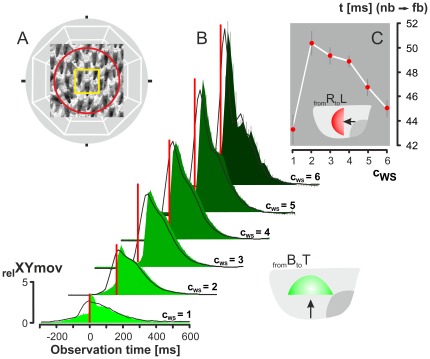
The time courses of wave strength of focus bees and their triggering neighbours.(A) Details about the assessment of the image-based relXYmov values (see Methods); yellow square gives the 60×60 px region of interest (ROI) around the selected focus bee; the red circle defines the near neighbourhood (r < 40 mm); the white lines in the background show the eight sectors of neighbourhood (dirNh = 1–8). (B) Time courses of the relXYmov values of focus bees at different wave strength levels (dirWAV = fromBtoT; cws = 1-6; n = 2908 wave incidents). The contours of the green areas show arithmetic means, vertical grey bars show mean errors. Black lines are means of relXYmov values of the triggering neighbours (radiusNh<40 m) regarding the paired, focus bee-related wave incidents; mean errors are not displayed here. Red vertical bars signify the time points t0 defined by the rapid onset of shimmering activity (quantified by the ordinate relXYmov values) of the focus bees. (C) How long does it take that information of shimmering is transferred from the neighbours in the far neighbourhood (radiusNh<100 mm) to the focus bees? Estimation exemplified for dirWAV = fromRtoL; abscissa, wave strength level; ordinate, time interval in ms in which information has been transferred, with means (red dots) ± SE (black vertical bars), n = 14 threshold levels (relXYmov = 1.0–2.3 in steps of 0.1) for the neighbourhood activity; ordinate values are calculated by weighted interpolation and cross correlation of the time courses between focus bees (fb) and their trigger neighbours (nb) of the same wave strength level (Nfb = 2824; Nnb = 29237).